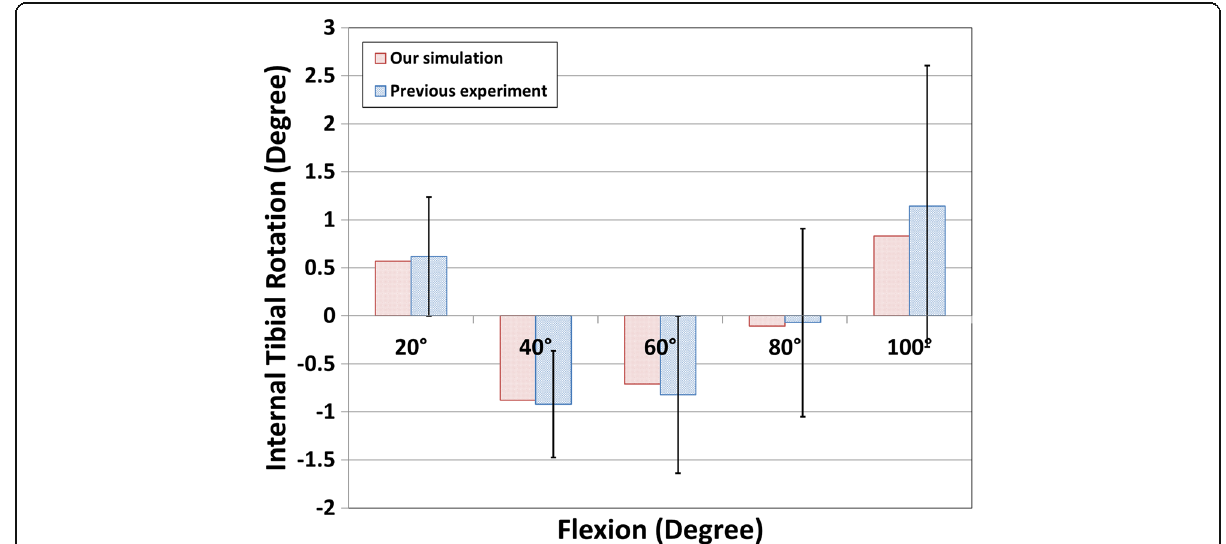
Fig. 5 Comparison of internal tibial rotation with previous study for validation of the TKA